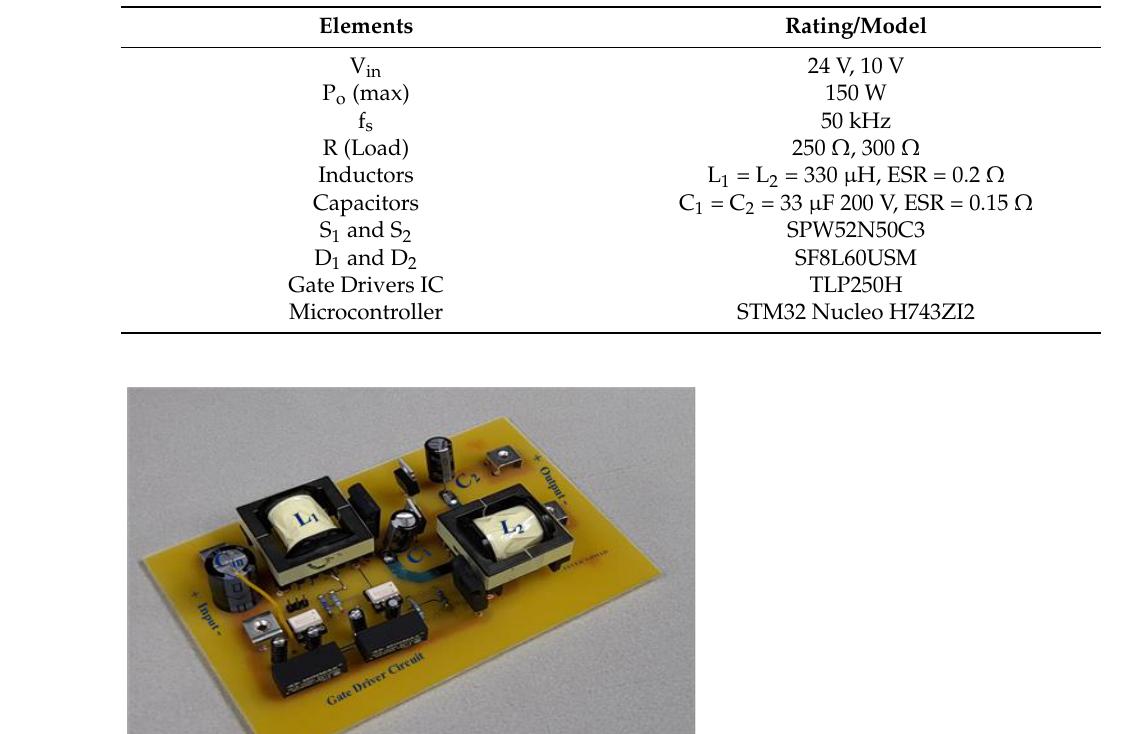
Table 2. Ratings of components.